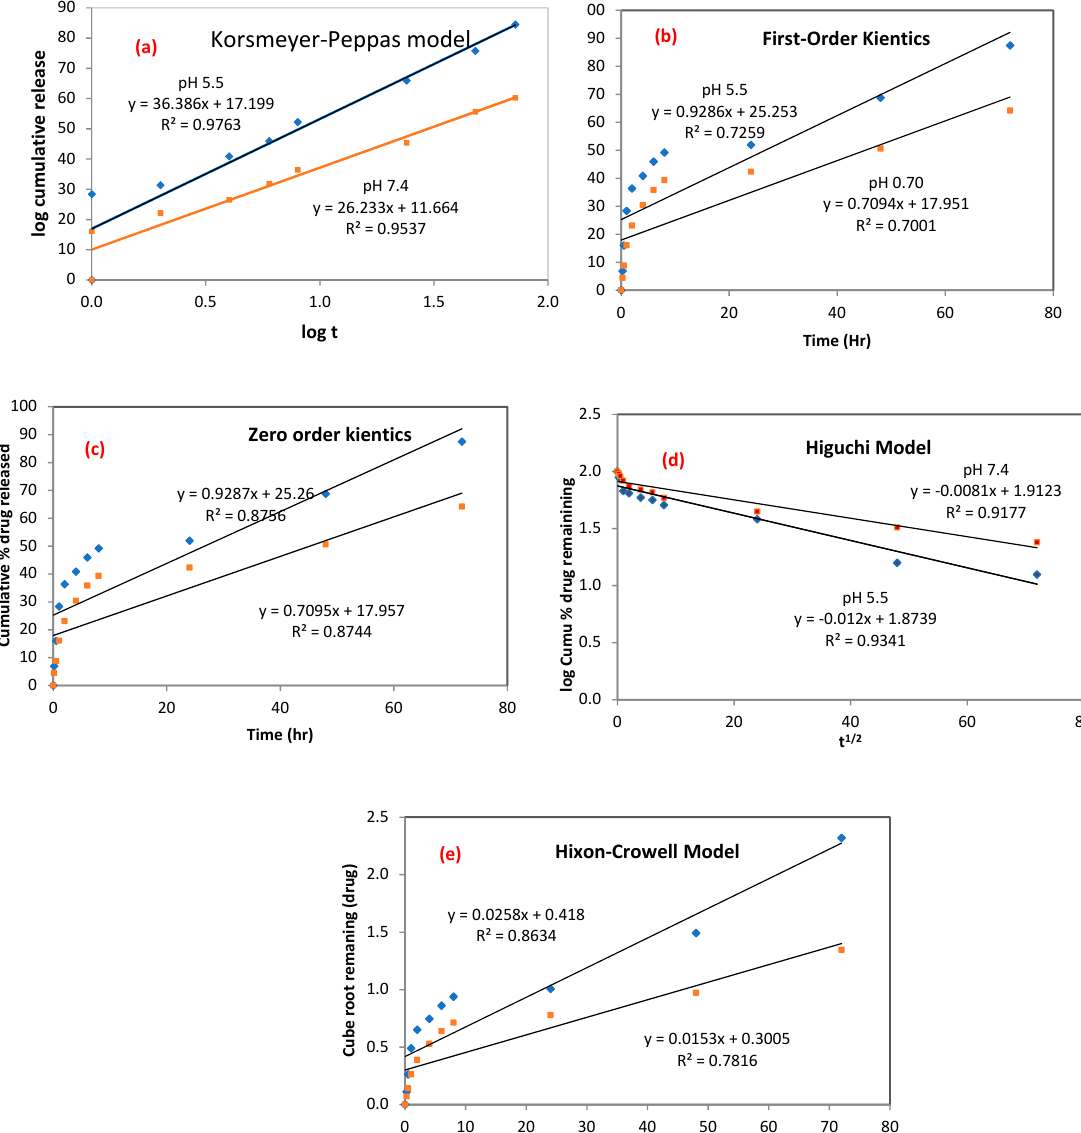
Figure 10. Kinetics drug release from nCA. ( a ) Korsmeyer–Peppas, ( b ) first-order kinetics, ( c ) zero-order kinetics, ( d ) Higuchi, and ( e ) Hixson–Crowell models. Table 4. The kinetic parameters of AFA released from the nCA/AFA nanocomposite using different pharmacokinetics models.